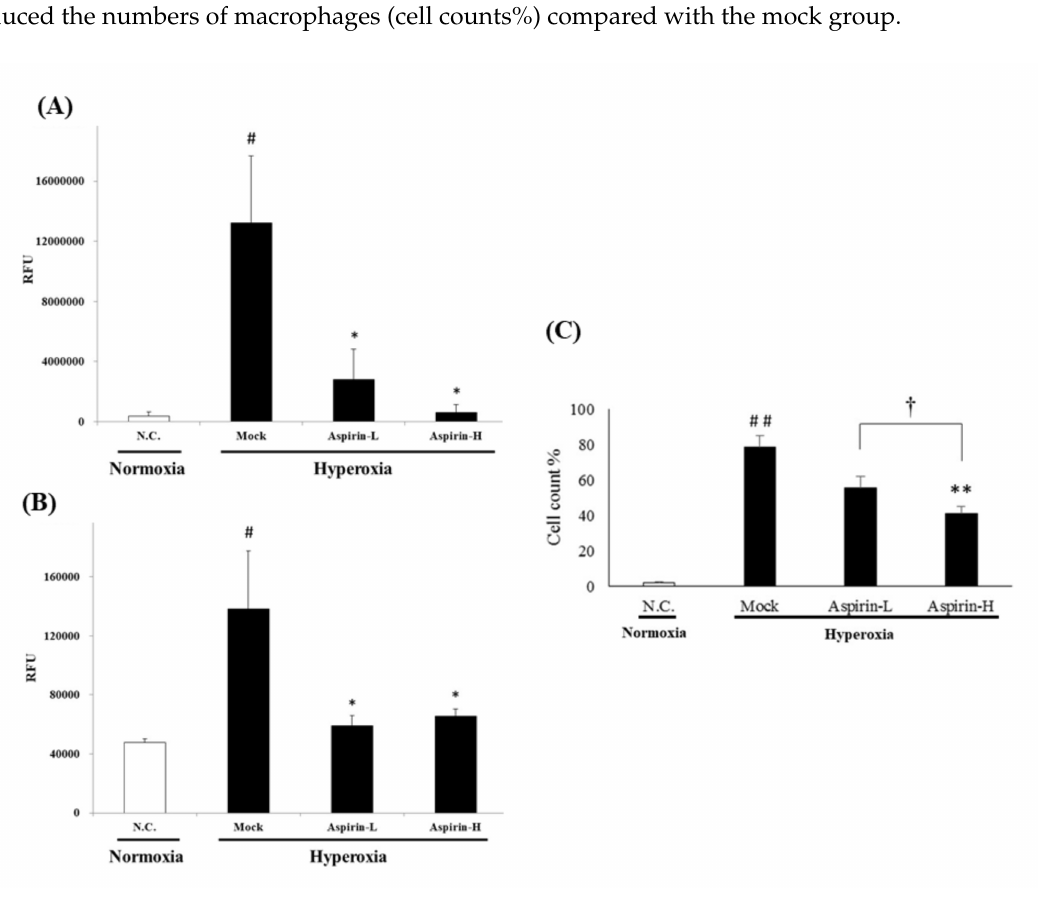
Figure 6. Quantification of reactive oxygen species (ROS) production in extracellular fluid ( A ) and intracellular fluid ( B ); the number of macrophages ( C ) of the bronchoalveolar lavage fluid (BALF) and from NF- κ B–luciferase transgenic mice after induction of hyperoxia for 72 h in the normal control (NC), mock, aspirin-L and aspirin-H groups. The reported values are expressed as the mean ± SEM ( n = 6). # p < 0.05, ## p < 0.01 vs. NC group. * p < 0.05, ** p < 0.01 vs. mock group. † p < 0.05 vs. aspirin-L